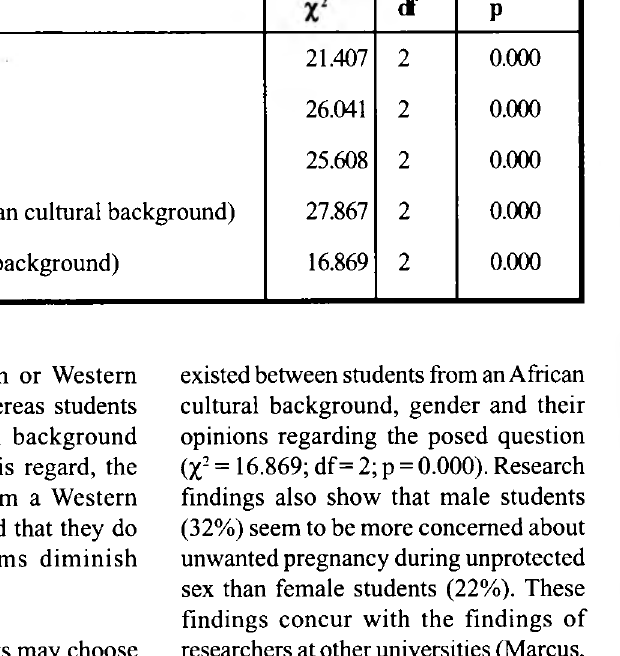
Tablel: The relationship between cultural background, gender and condom use